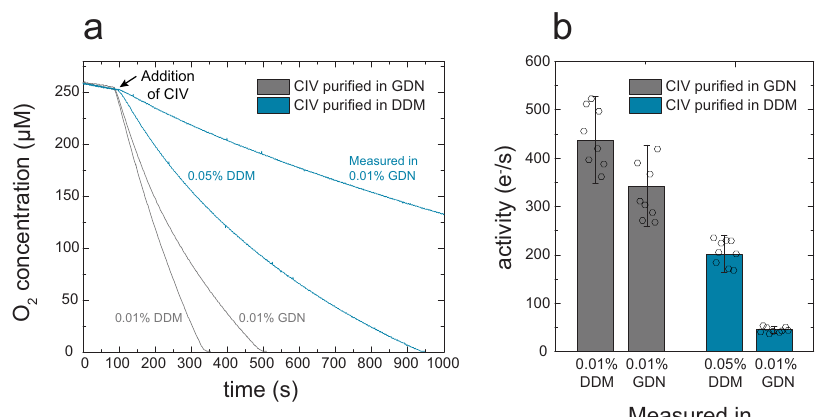
Fig. 6 Oxygen reduction activity. a Concentration of O 2 as a function of time upon addition of CIV (9 nM pre-incubated in 50 mM KH 2 PO 4 , pH 6.5, in detergent as labeled “ puri fi ed in ” ) to the oxygraph chamber containing 10 mM ascorbate, 50 µ M cyt. c , 0.1 mM TMPD, 50 mM KH 2 PO 4 at pH 6.5 (with either DDM or GDN as shown speci fi ed by “ measured in ” ). The background slope recorded before addition of CIV was subtracted from that measured after CIV addition. The differences are shown in panel b . Shown is the average with the standard deviations ( n = 8-9, three independent